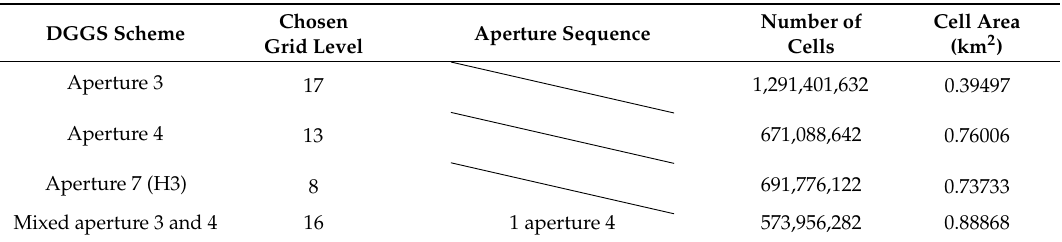
Table 2. Chosen grid level for di ff erent icosahedral hexagonal Discrete Global Grid System (DGGS) schemes. The projection for all schemes is Snyder equal-area polyhedral projection.